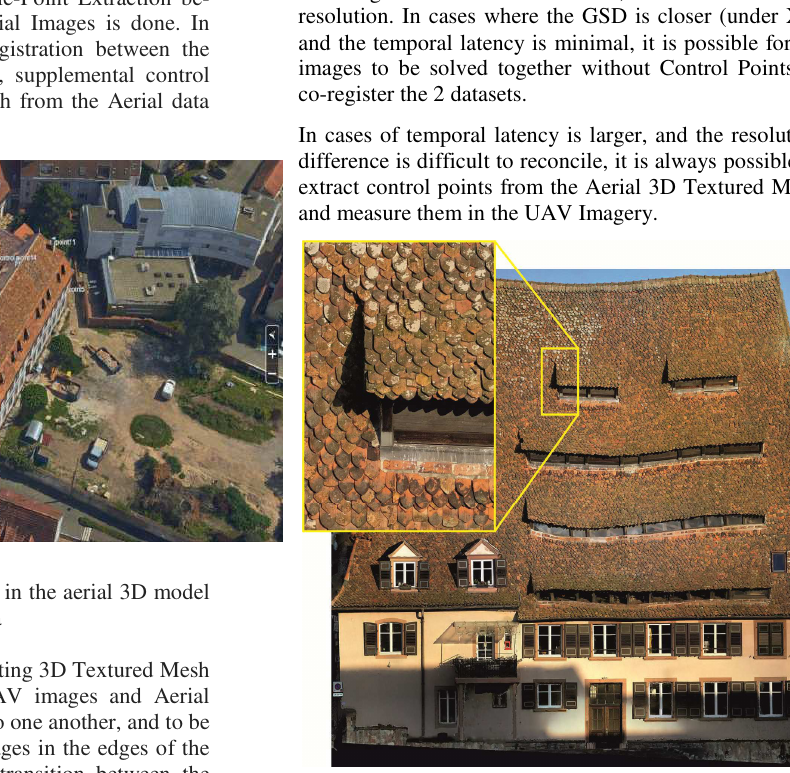
Figure 7: Example of a produced Orthophoto captured of the roof with a resolution of a 5 mm